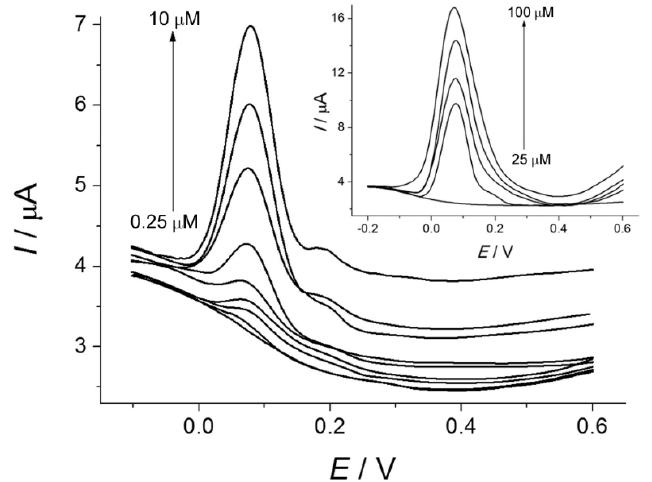
Figure 12. Differential pulse voltammograms of quercetin at the sensor based on MWCNTs and poly(gallic acid) in phosphate buffer pH 7.4. Reprinted from [32] with permission from Elsevier.